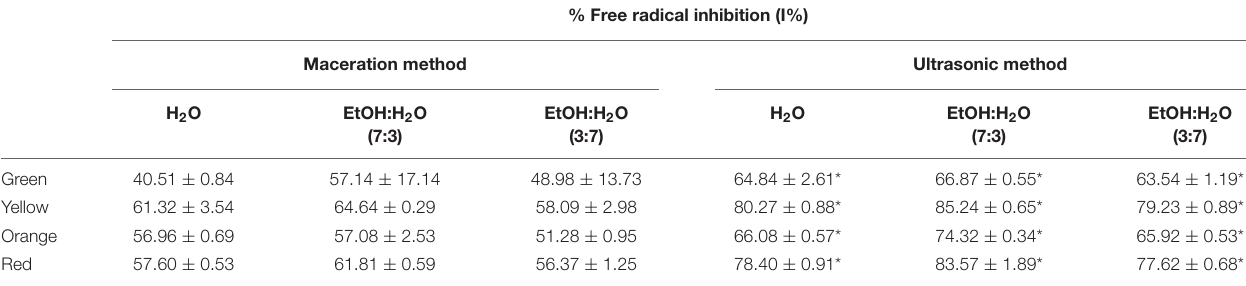
TABLE 4 | DPPH radical scavenging activity (I%) of the different A. unedo fruit